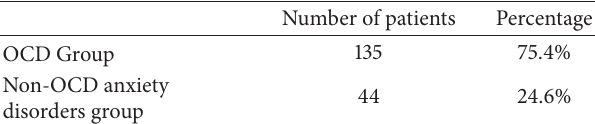
Table 1: Breakdown of primary diagnosis in